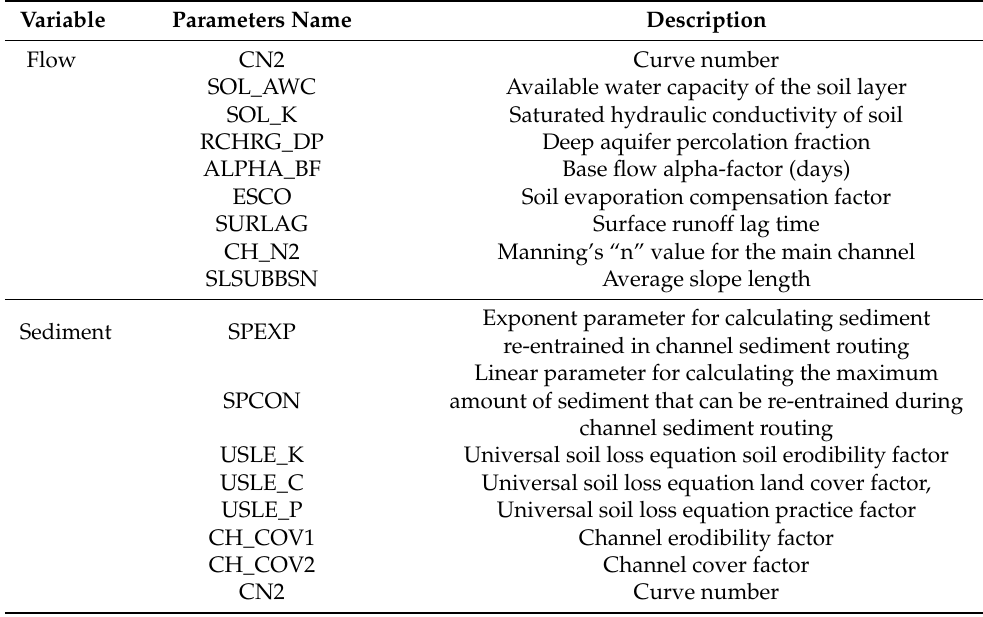
Table 4. List of selected parameters for runoff and sediment